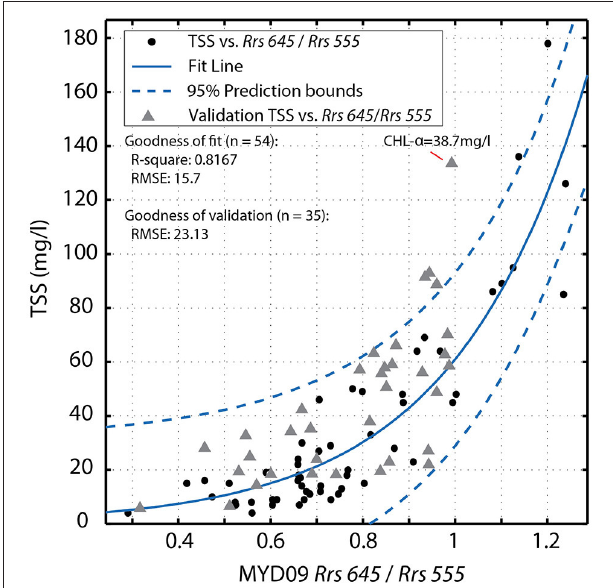
FIGURE 3 | Model produced by Equation 1 for the estimation of TSS from MYD09 reflectance with in situ data collected by TCEQ (black circles) and validation dataset (gray triangles) collected by Paudel and Montagna